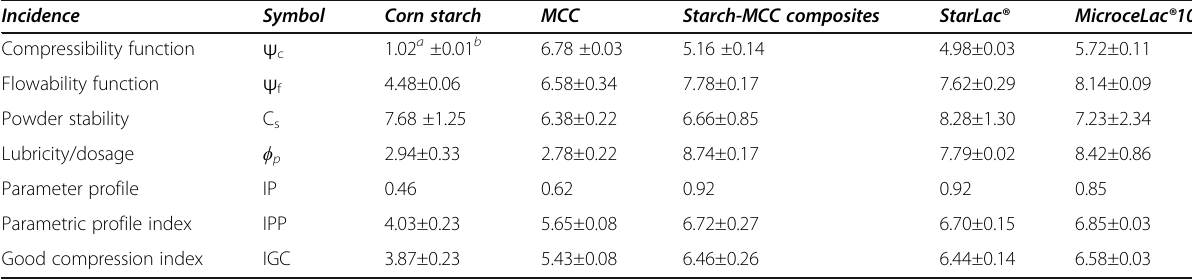
Table 3 Incidence values of the studied excipients Incidence Symbol